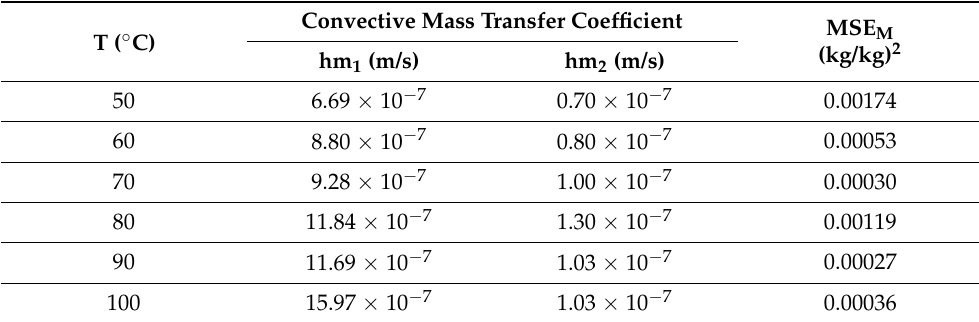
External (h m1 ) and internal (h m2 ) convective mass transfer coefficients for each drying temperature. Convective Mass Transfer T ( ◦ C)